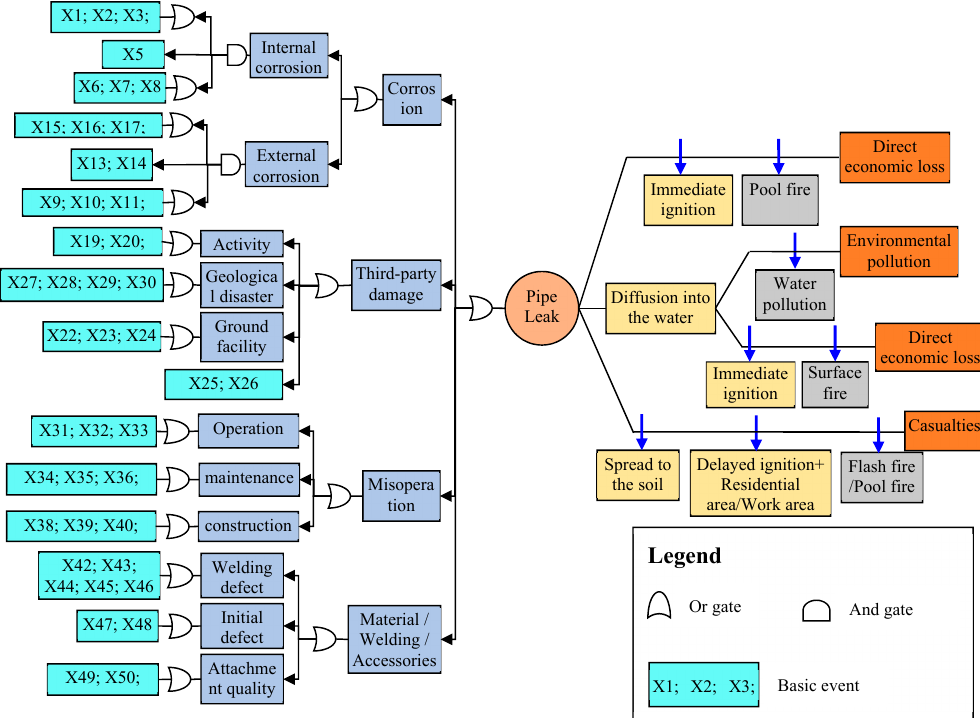
Figure 7. BT model diagram of heavy oil gathering pipeline.